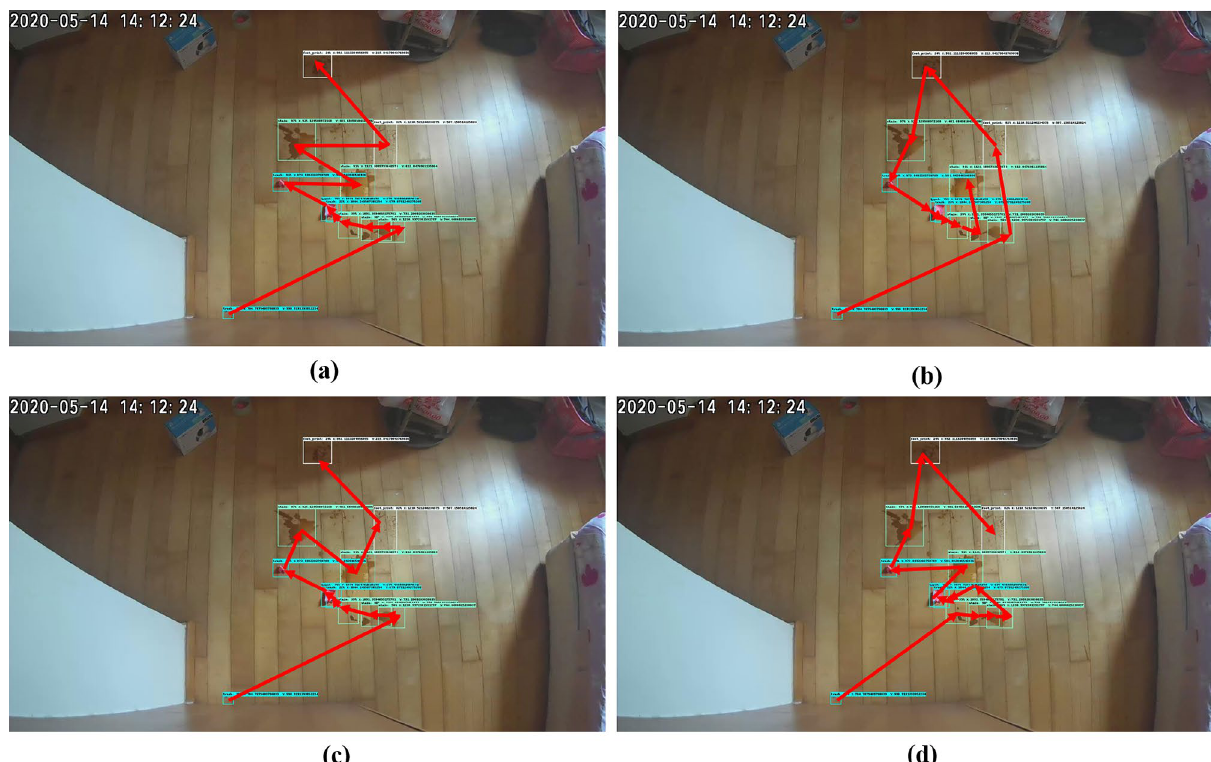
Figure 8. The trajectories of the tested method for workspace-2. ( a ) zigzag; ( b ) spiral; ( c ) greedy search; ( d ) ACO.